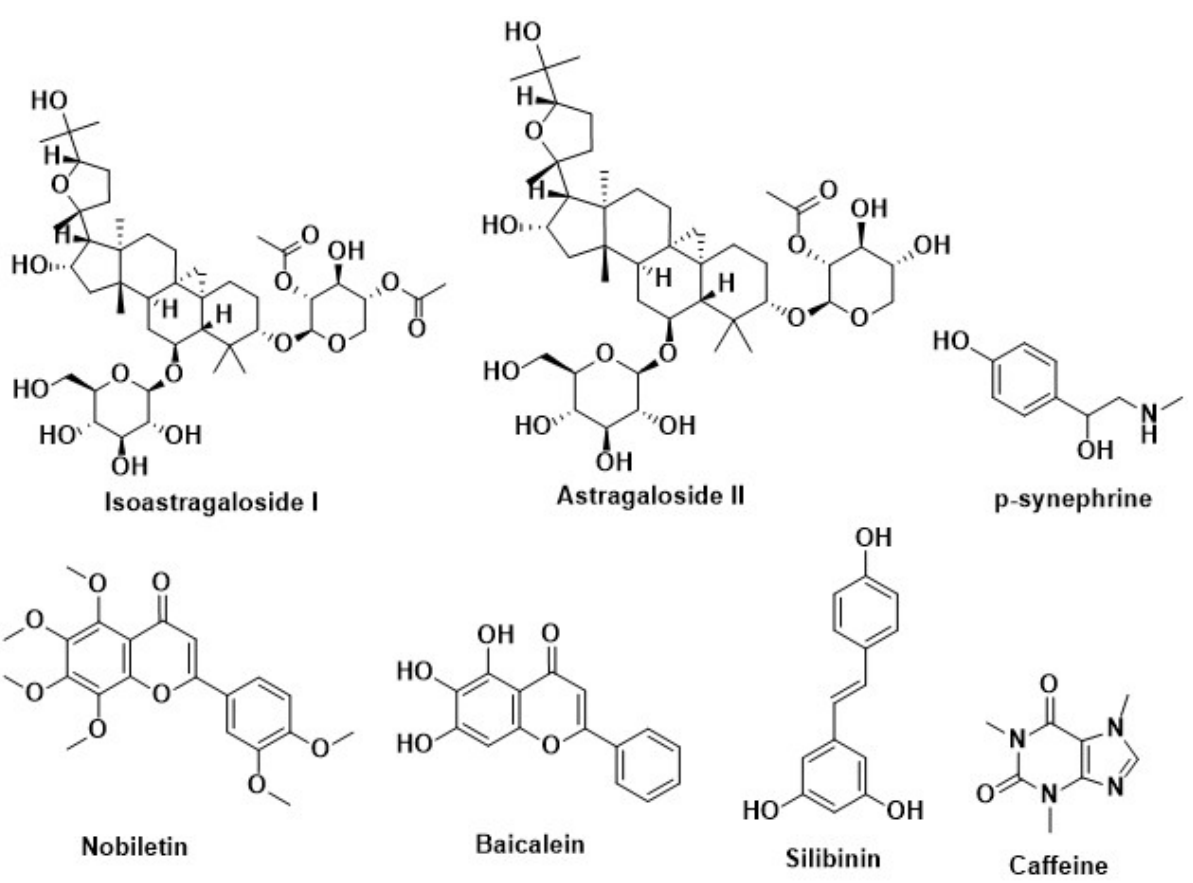
Figure 7. Chemical structures of phytocompounds against diabetes.